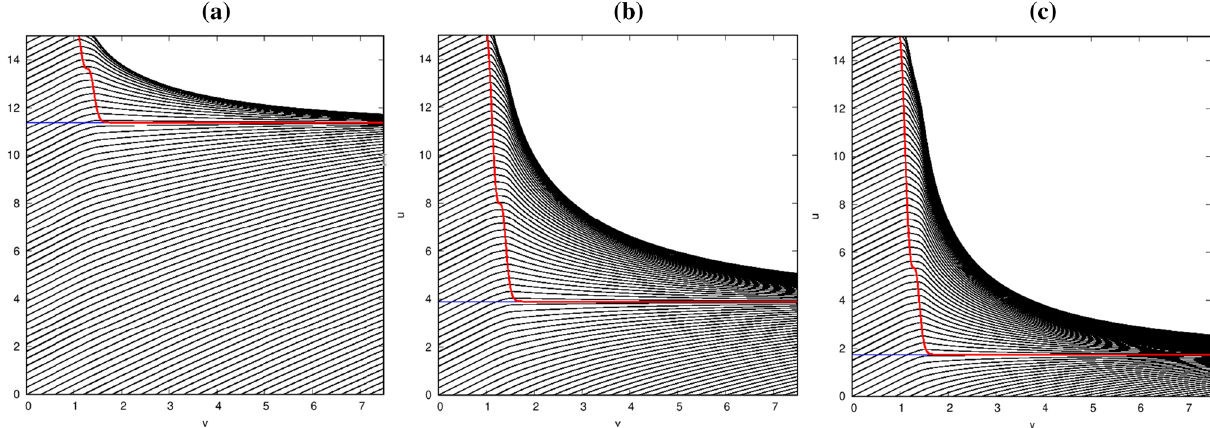
Fig. 5 Penrose diagrams of spacetimes emerging from evolutions with α = 0 and γ = − 0 . 1. The field amplitudes ˜ p s = ˜ p h were equal to a 0 . 02, b 0 . 04 and c 0 .